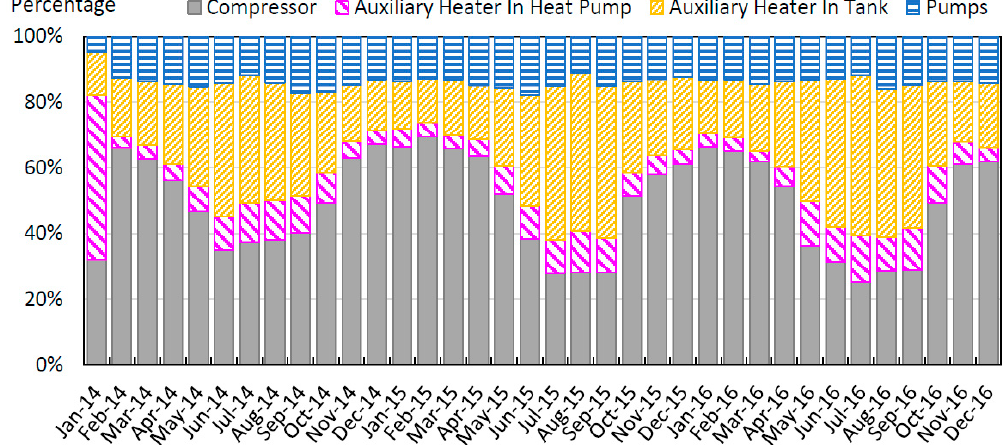
Figure 24. The percentage share of different system components in the total monthly electrical consumption of the space heating and hot water system.